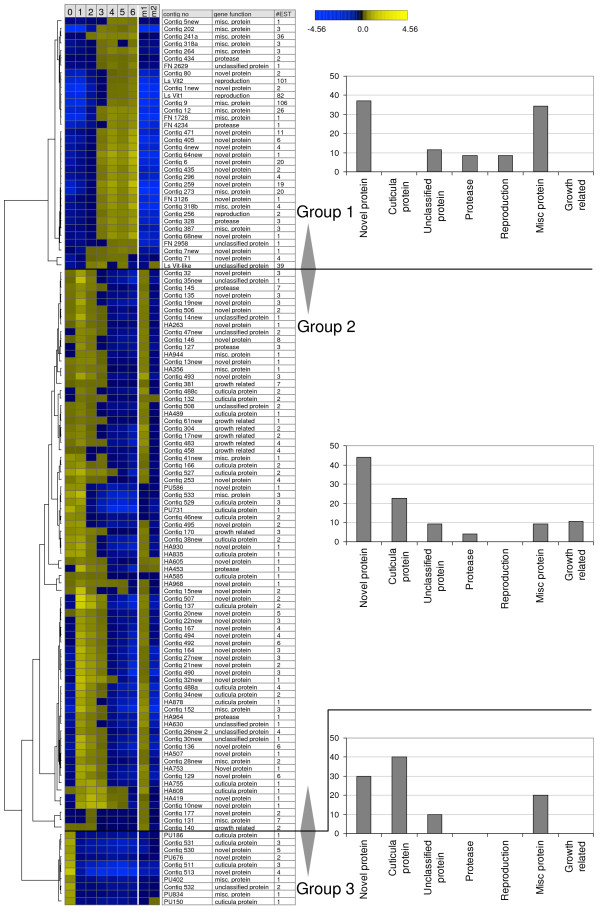
Hierarchical clustering of merged contigs. The columns of the heat map represents mean group signal (mean EST log, sample vs. reference). Column 0 represents pre-adII females, columns 1–6 represents adult female post molting growth time points T1–T6, respectively (according to Fig 2) and columns m1 and m2 represents male groups, preadII and adults, respectively. Three distinct patterns can be seen for differentially transcribed genes in adult females; the upper sub-tree shows genes up-regulated from T2 and during most of the maturation phase (group 1). The middle sub-tree shows genes that are turned on in T1 and but down-regulated during the post molting growth (group 2). The lower sub-tree shows genes transcribed in pre-ad II but down regulated throughout post molting growth in adult phases of the experiment. Male, pre-adII and adult transcription levels of genes regulated during female molting and post molting growth are shown in the right section of the dendrogram (m1 and m2) for sex comparison.